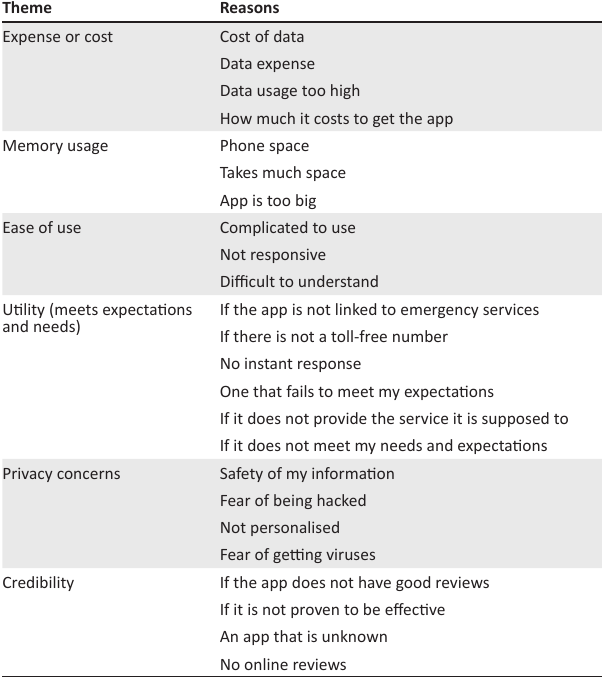
TABLE 5: Reasons preventing participants from using personal safety apps.